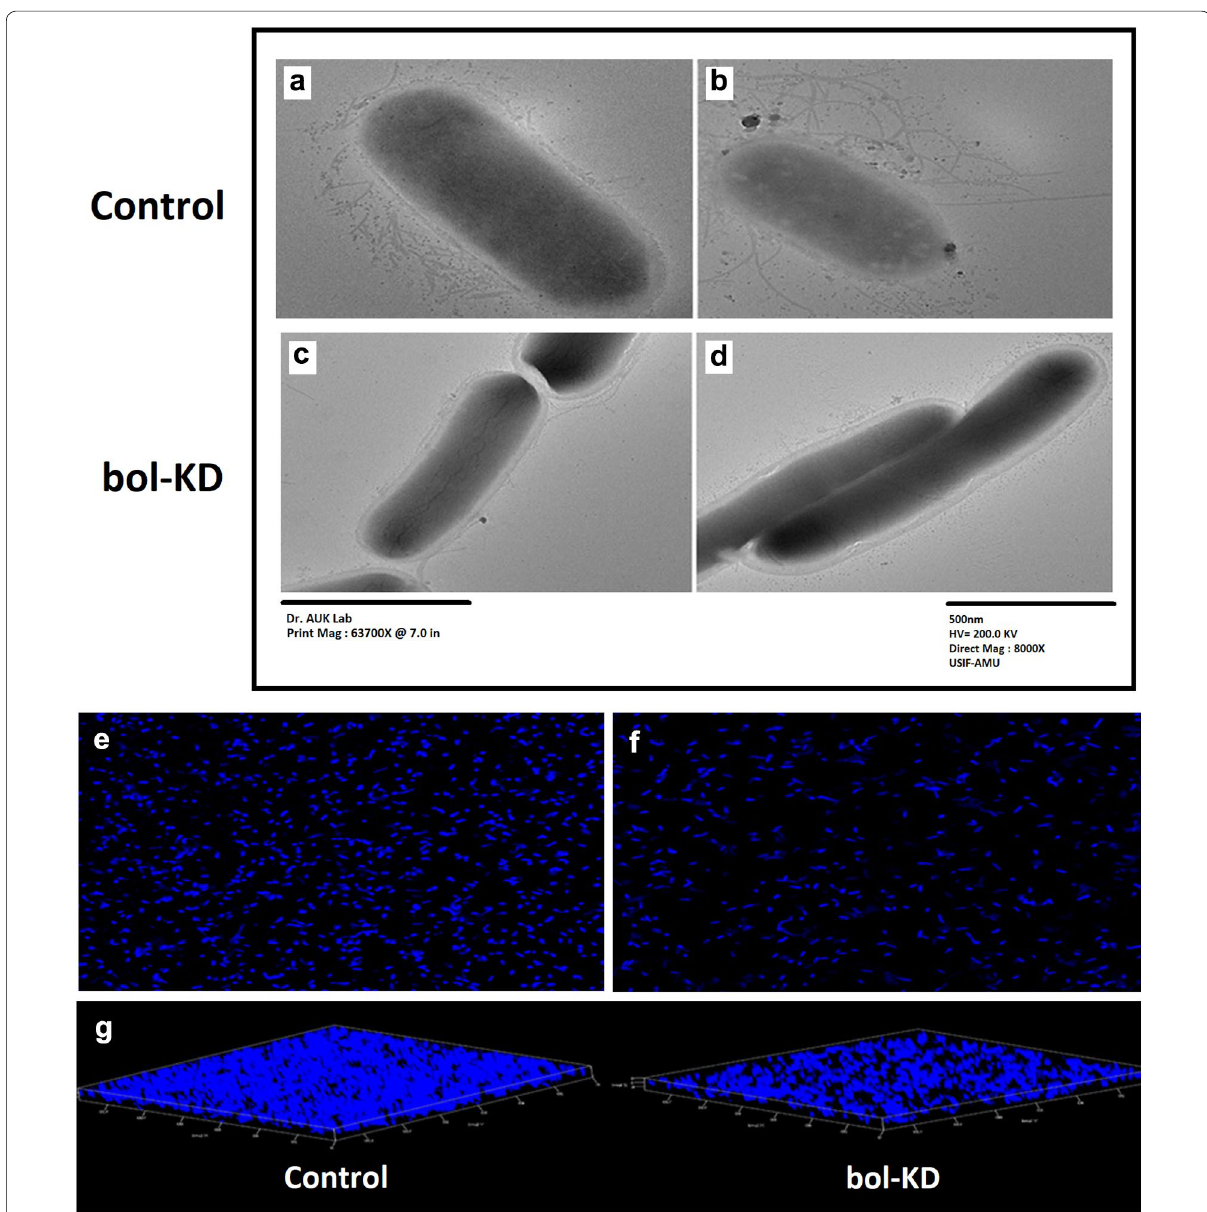
Fig. 5 TEM images from different visual fields. a , b Control, c , d CRISPRi treated bol-KD cells. Biofilm cell adherence through CSLM ( e – g ). e Control, f treated bol-KD, g biofilm thickness and its conglomeration comparison between control and bol-KD